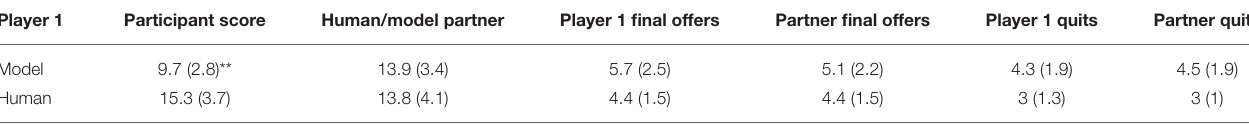
TABLE 5 | Comparison of model performance to human performance in Experiment